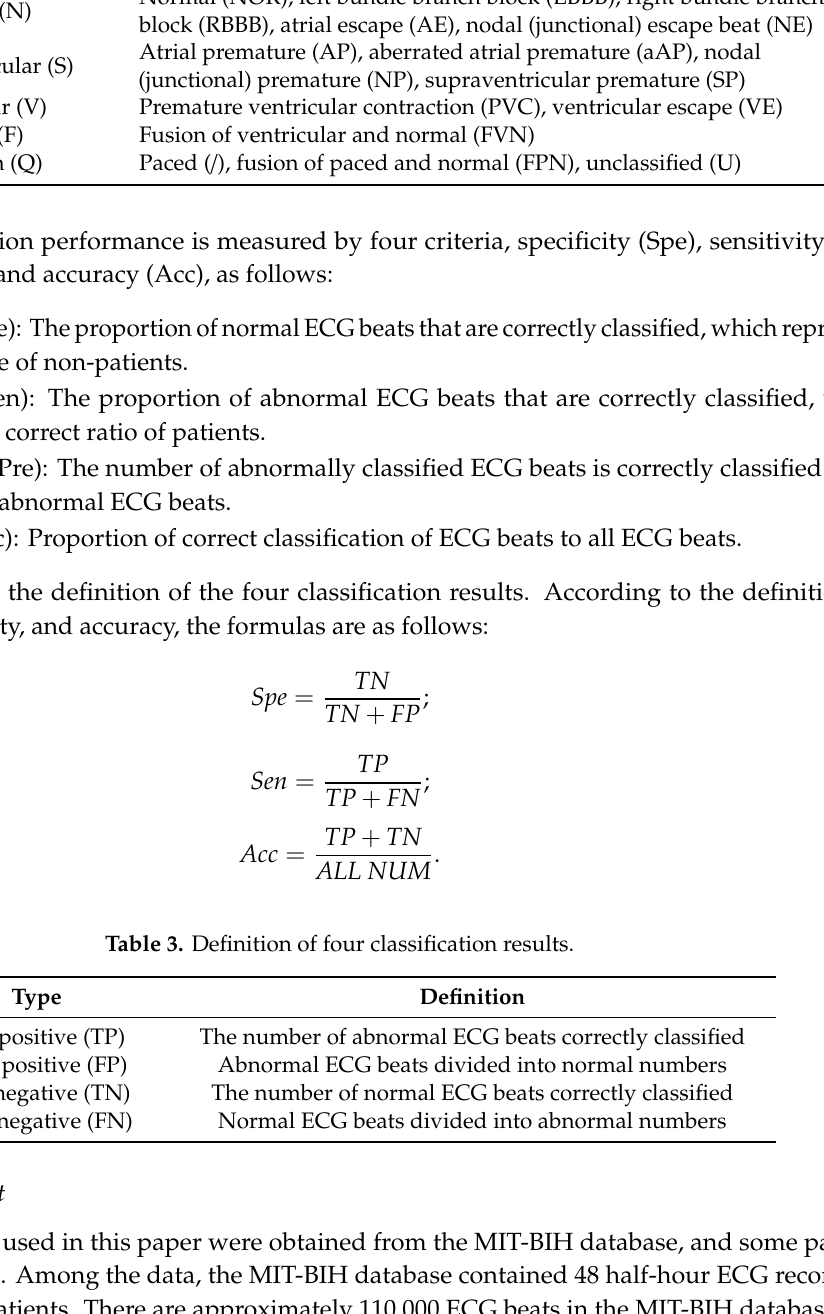
Table 2. Classification of electrocardiogram (ECG) beats using the AAMI standard [38]. AAMI ECG Beat Class